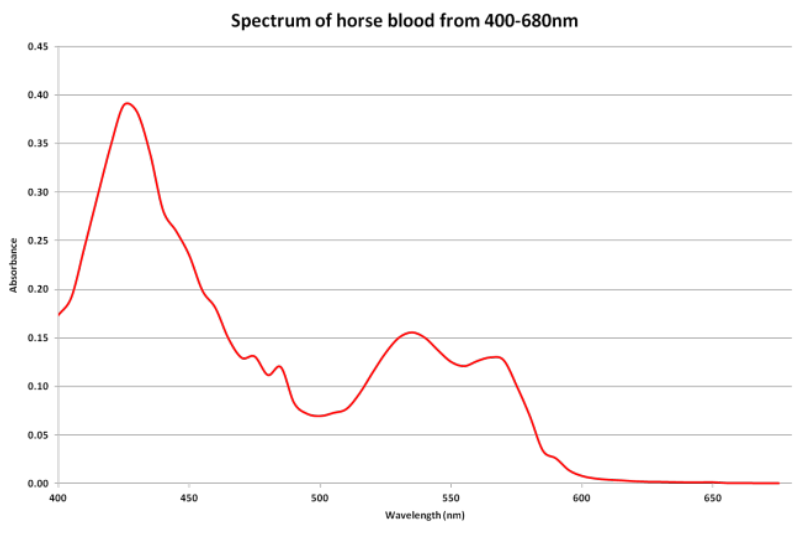
Figure 2. Spectrum of blood from 400 – 680 nm.